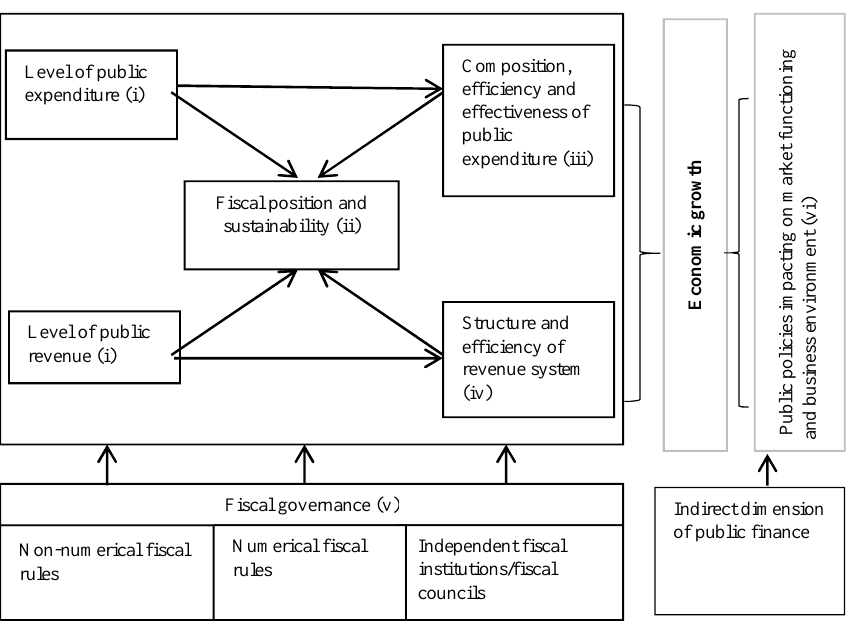
Figure 1. Quality of public